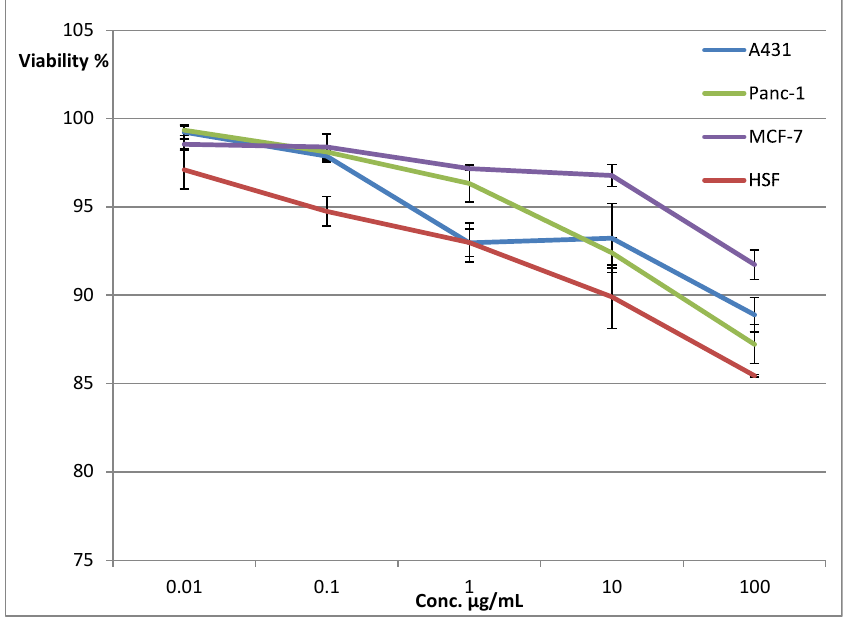
Figure 2. Viability percentages of the cancerous cells A431 (human epidermoid skin carcinoma), Panc-1 (pancreatic cancer), MCF-7 (breast adenocarcinoma) and the normal HSF fibroblast cells (human skin fibroblast cells) treated with different concentrations of the A. absinthium essential oil.